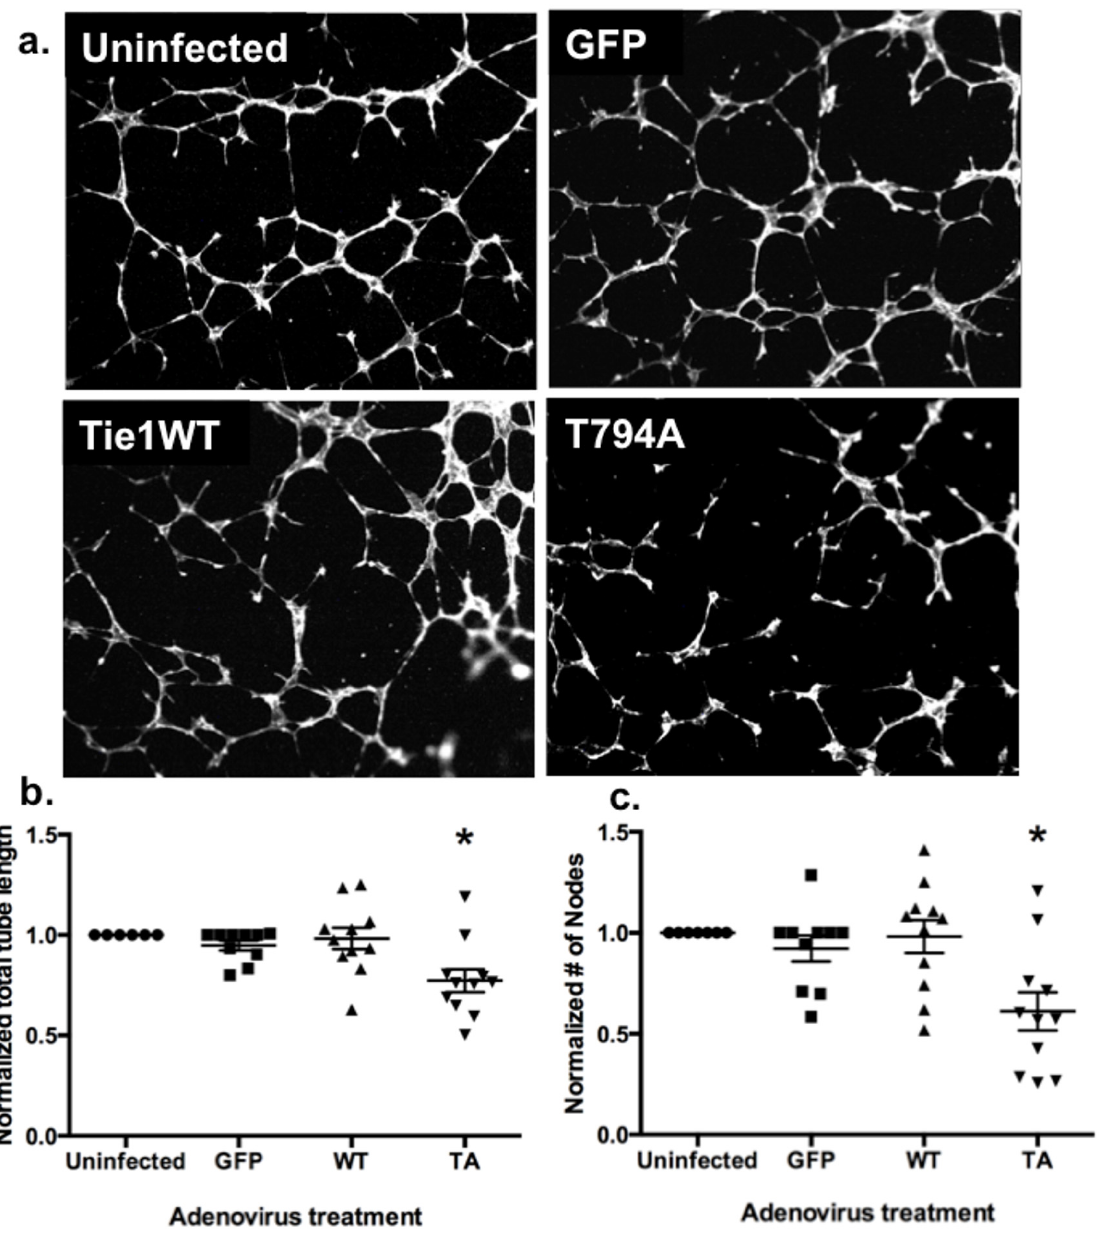
Fig 3. The Tie1 T794 mutant disrupts endothelial tube formation. a Representative images of HUVECs left uninfected or infected with adenoviruses encoding GFP, Tie1-WT, or Tie1-T794A, plated on Matrigel and allowed to form tubes for 6 hours. b, c Quantification of endothelial tube networks in vitro . Cells expressing the T794A mutant formed significantly shorter tubes ( b ; * , multiple comparisons P (cid:1) 0.02) with fewer nodes and branches ( c ; * , multiple comparisons P < 0.01) (n = 11 independent experiments with 4 or more images per